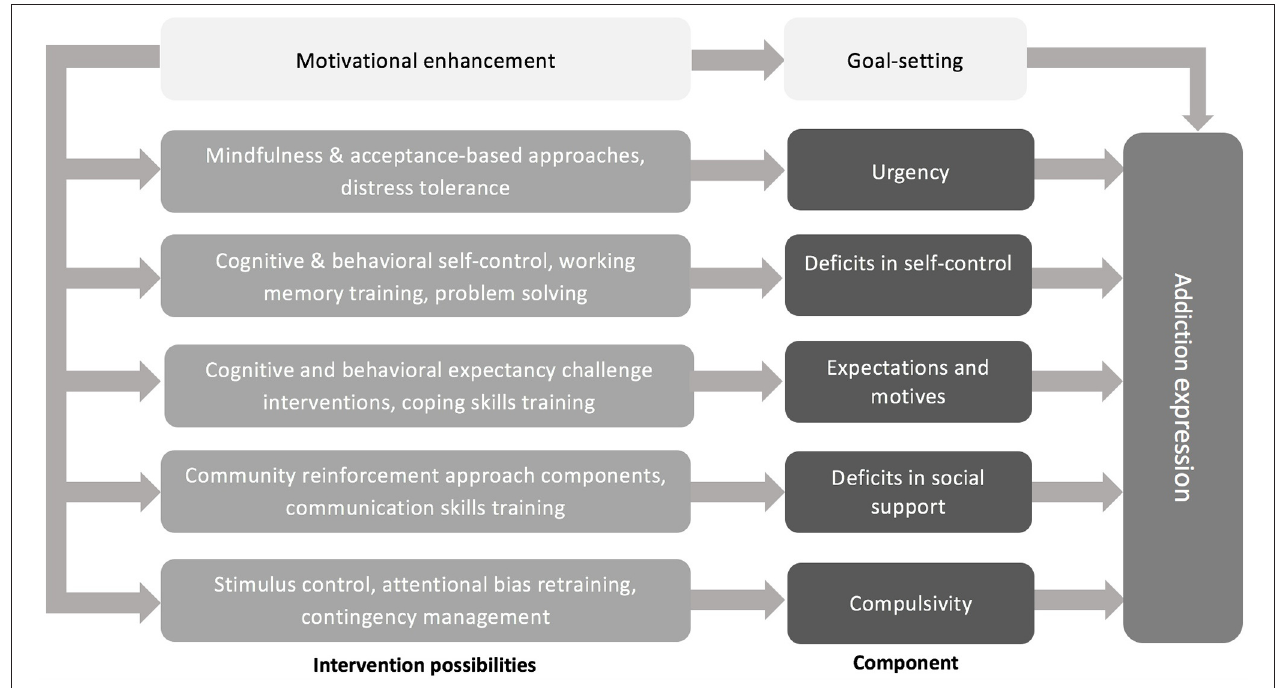
FIGURE 1 | A working model of the component model of addictions treatment depicting component vulnerabilities and the corresponding intervention